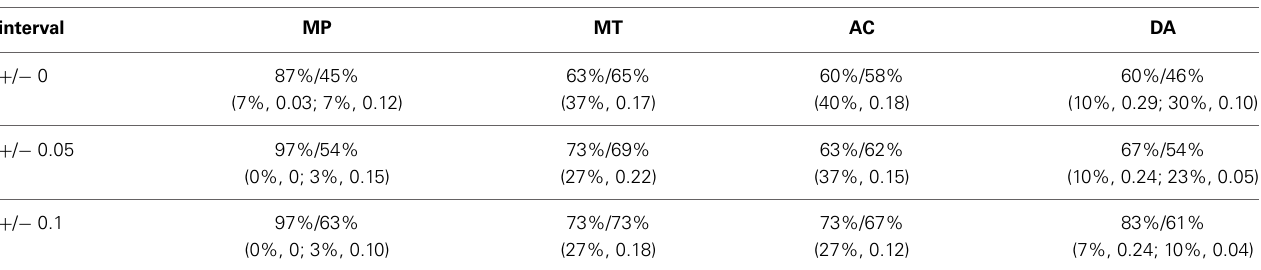
Percentages of responses within the coherence intervals/percentages of responses within the coherence intervals predicted from the size of the intervals. The numbers in parentheses below each row are the percentages of responses below and above the interval (only below for MT and only above for AC) and the median distance of the outside responses from the border of the interval. Rows 2, 3 present the same information but with intervals extended on both sides by 0.05 and 0.1,